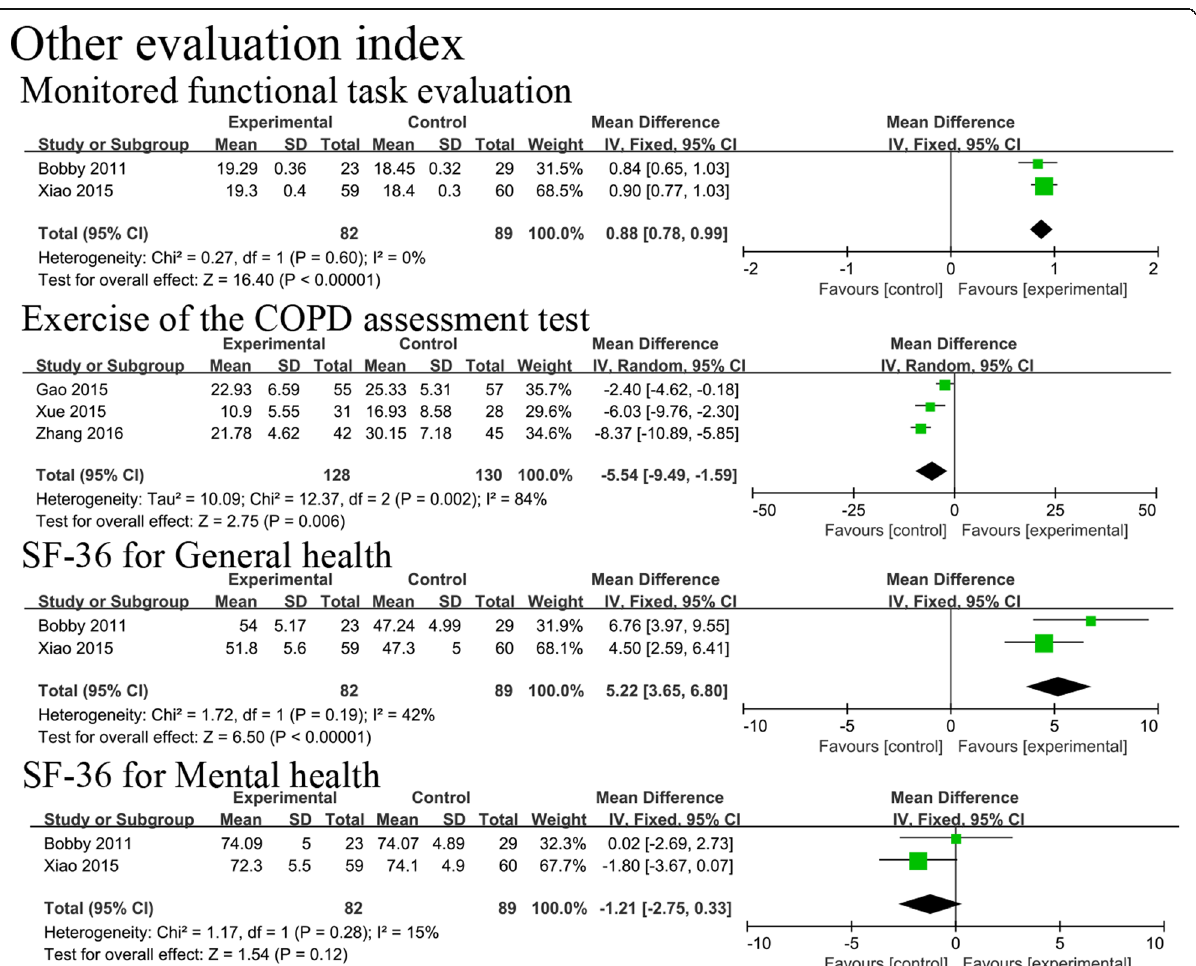
Fig. 6 Effects of Qigong on the results of the Monitored Functional Task Evaluation, COPD Assessment Test for exercise, SF-36 for General Health, and SF-36 for Mental HealthSF-36, Short Form-36 Health Quality